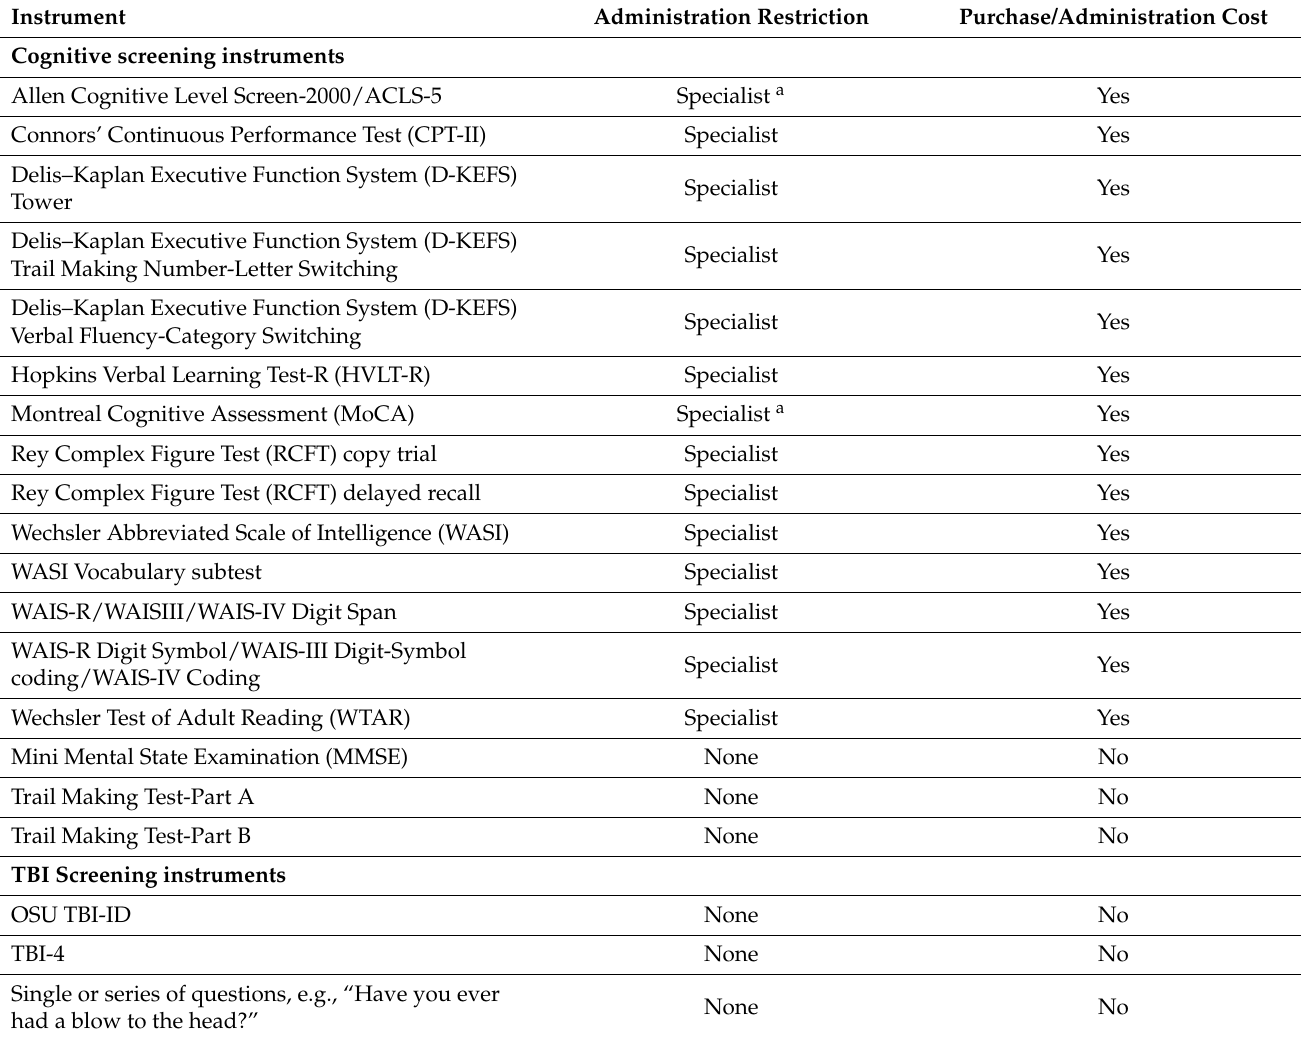
Table 3. Instruments regularly screening for the presence of brain injury or cognitive